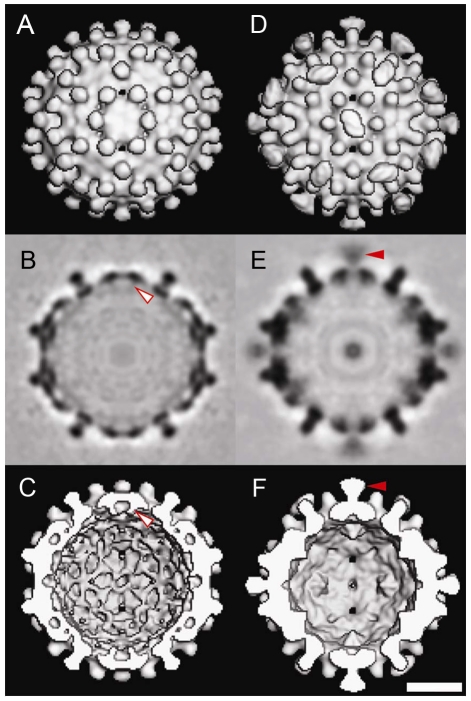
Three-dimensional structures of Cp183 Capsid and Cp183 Capsid/SRPKΔ.Cp183 capsid (A, B, C) and capsid/SRPKΔ (D, E, F) are displayed as exterior views (A, D), gray scale central sections (B, E), and interior views (C, F). Surface-shaded representations were contoured to account for 100% of the expected protein volume for a Cp183 capsid. The closed red arrow identifies the external SRPKΔ density at twofold vertices; the open red arrow highlights that the interior density attributable to the CTDs. Binding of SRPKΔ correlates with remodeling the capsid interior (compare B, C with E, F) resulting in the loss of CTD density under twofold vertices. All views are along an icosahedral twofold axis. The scale bar represents 10 nm.